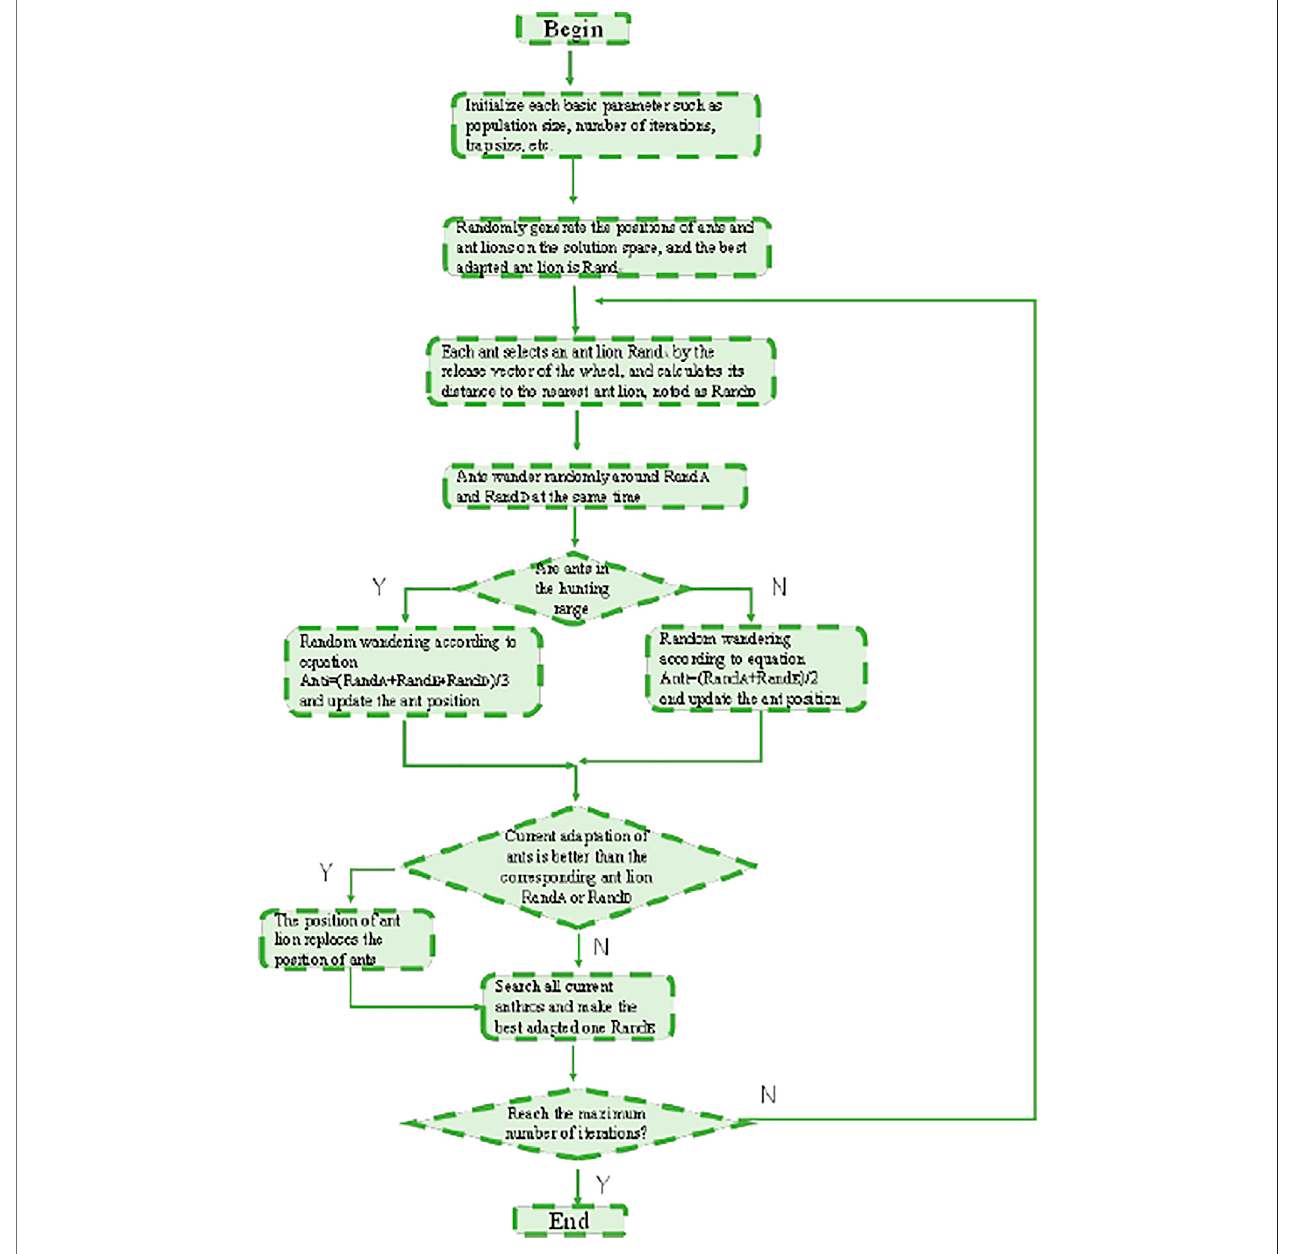
FIGURE 6 | Flow chart of improved ALO